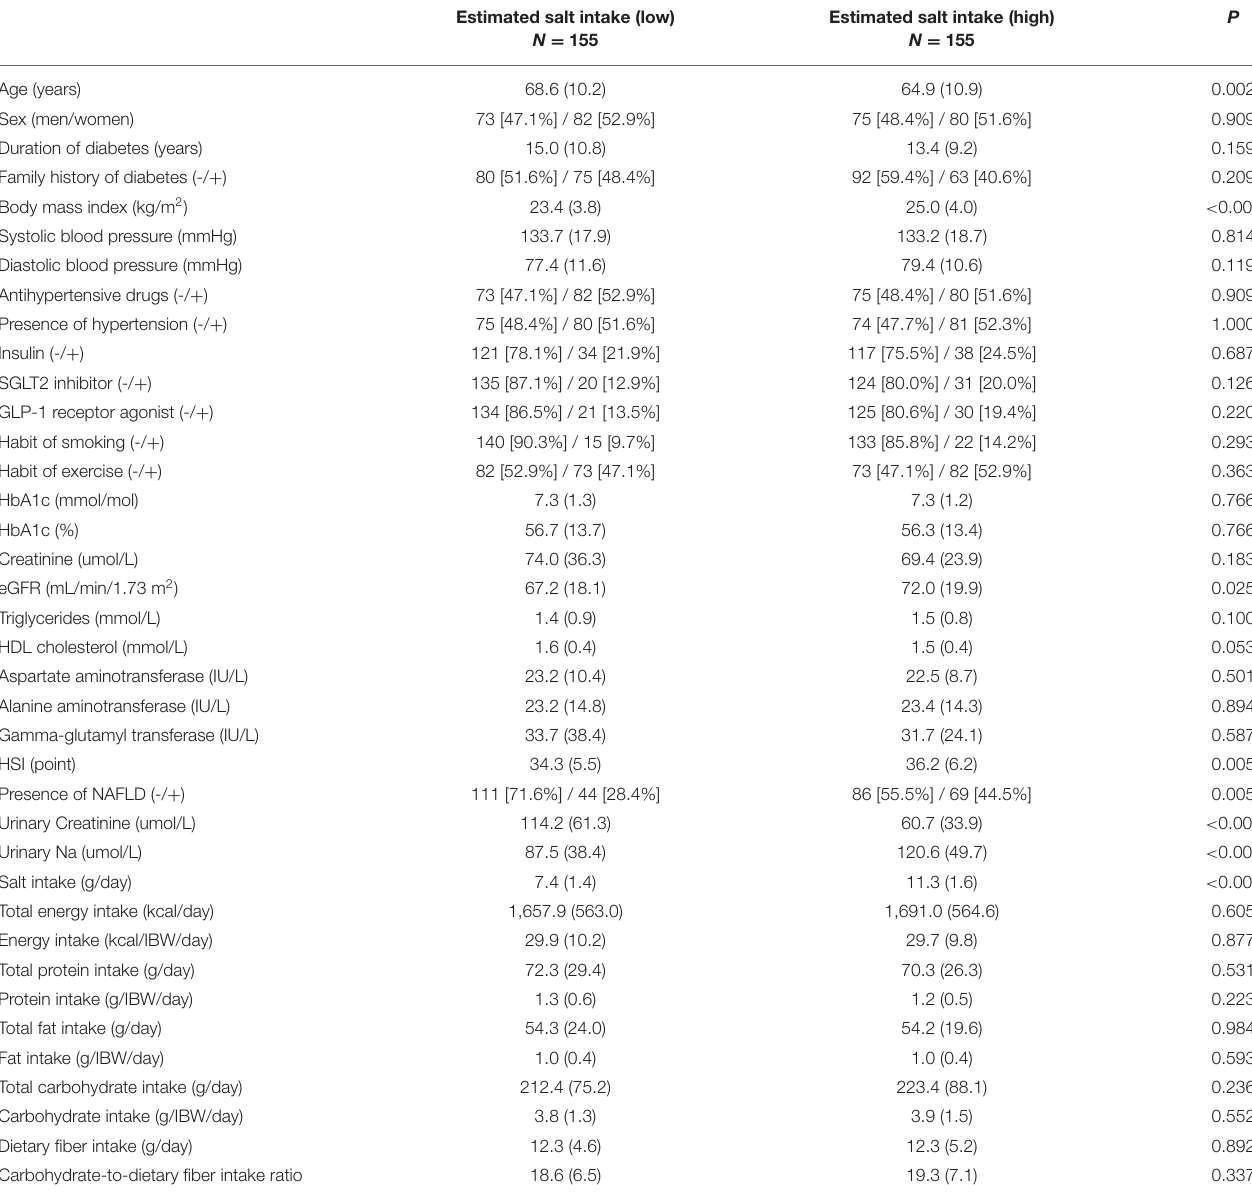
TABLE 2 | Clinical characteristics according to salt